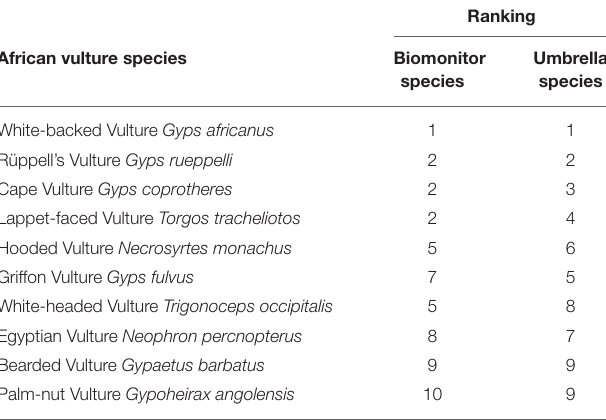
TABLE 7 | Ranking of the 10 African vulture species in terms of their suitability as (i) an avian biomonitor species, and (ii) an umbrella species for all 10 African vulture